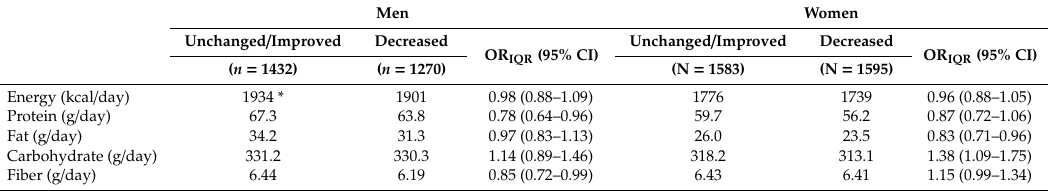
Table 2. The association between macronutrient intake and the lung function among healthy population.